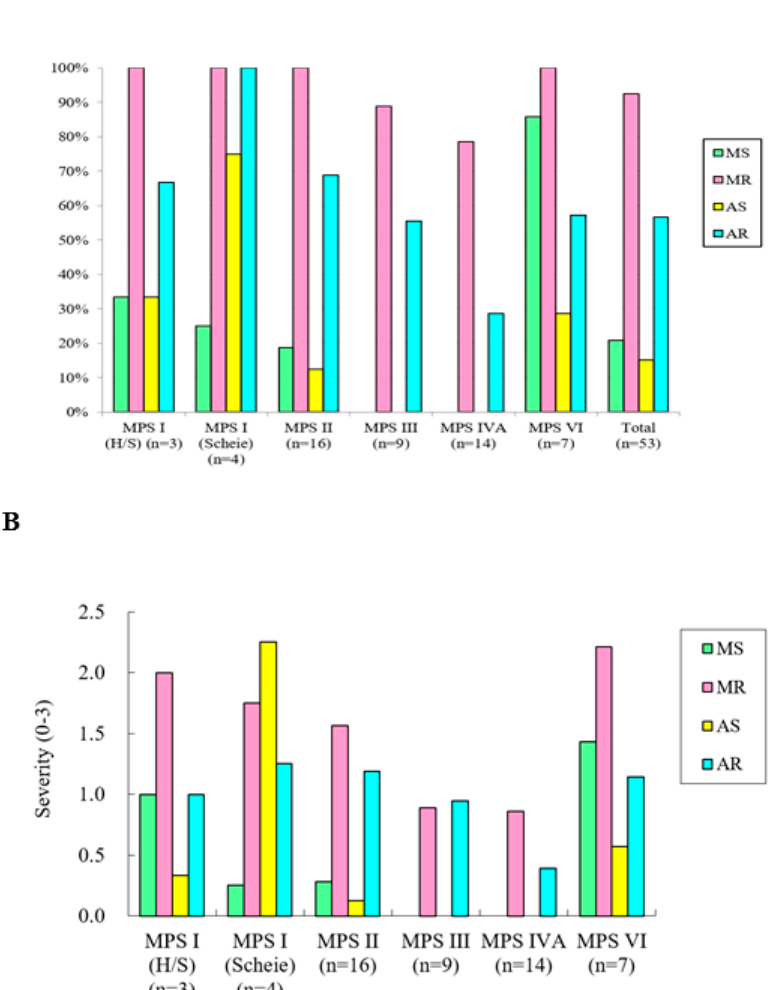
Figure 3. ( A ) Incidence of valvular heart disease by MPS type in the 53 patients. ( B ) Mean severity scores of valvular heart disease by MPS type in the 53 patients. Severity of valvular stenosis and regurgitation (MS, MR, AS, AR) was estimated and graded as follows: 0 (none), 1 (mild), 2 (moderate), and 3 (severe). MPS, mucopolysaccharidosis; MS, mitral stenosis; MR, mitral regurgitation; AS, aortic stenosis; AR, aortic regurgitation; H / S: Hurler-Scheie. Table 3. Mean severity scores of valvular heart disease by MPS type in the 53 patients. 0, normal; 1, mild; 2, moderate; 3, severe. Values are displayed as mean (standard deviation).